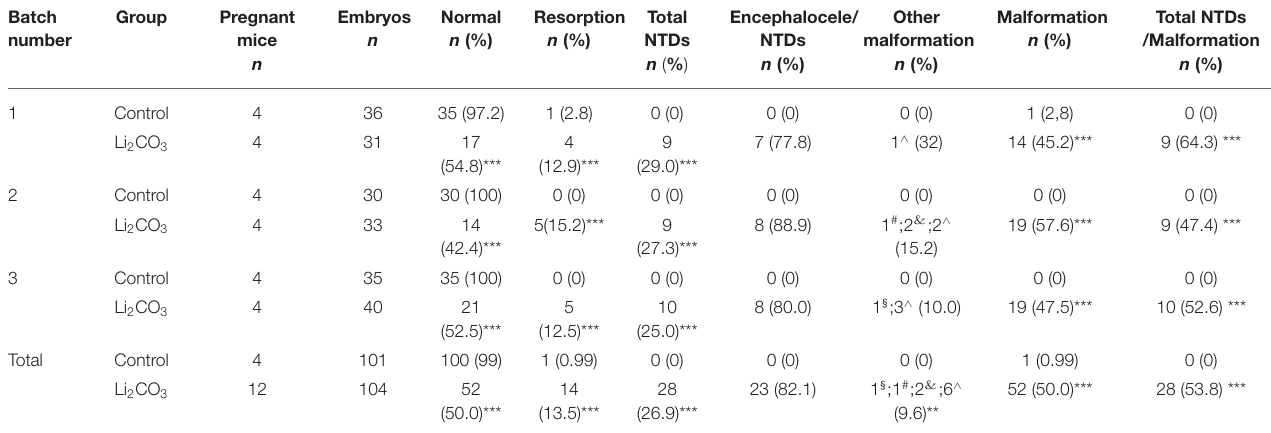
TABLE 2 | Embryonic phenotypes in C57BL/6 mice induced by 350 mg/kg of Li 2 CO 3 . Batch number